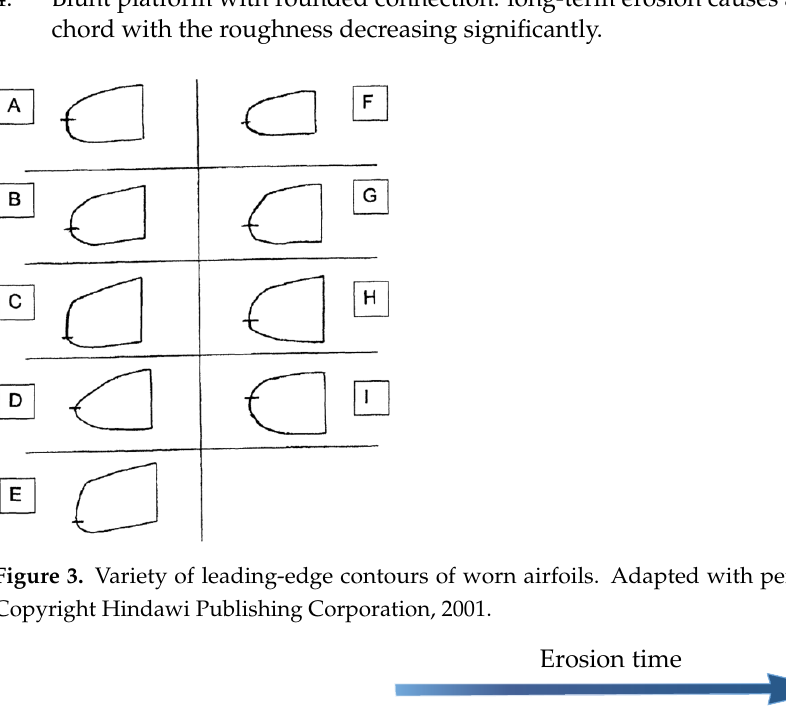
Figure 3. Variety of leading-edge contours of worn airfoils. Adapted with permission from [32], Cop- yright Hindawi Publishing Corporation, 2001.